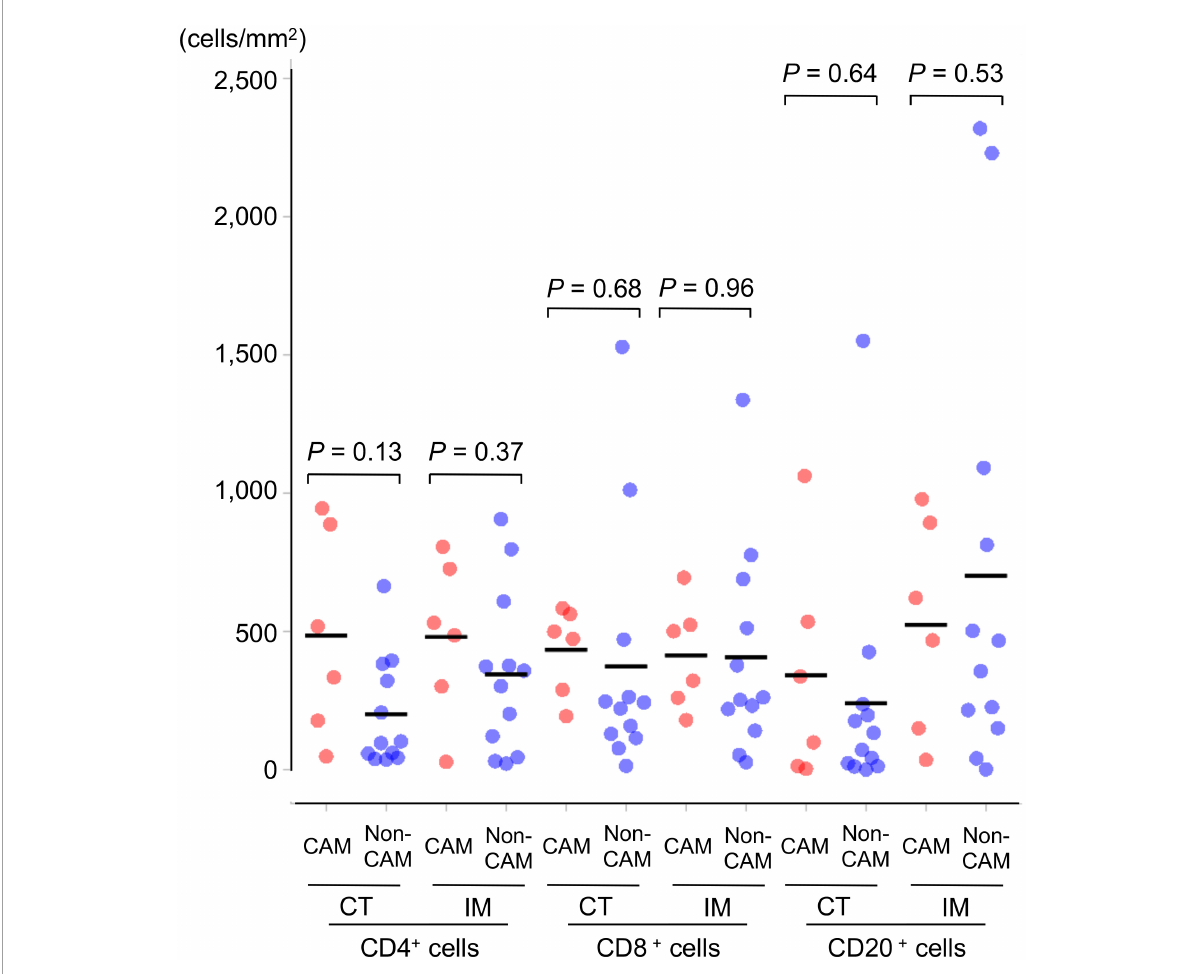
FIGURE1 Density of TILs in 6 CAM patients and 12 non-CAM controls. The density of tumor-infiltrating CD4 + T cells, CD8 + T cells, and CD20 + B cells in the CT and IM areas of the cancer tissue was analyzed by computerized quantitative assessment using the bioimage analysis software QuPath. Horizontal lines denote the mean. CAM, cancer-associated myositis; TILs, tumor-infiltrating lymphocytes; CT, central tumor; IM, invasive